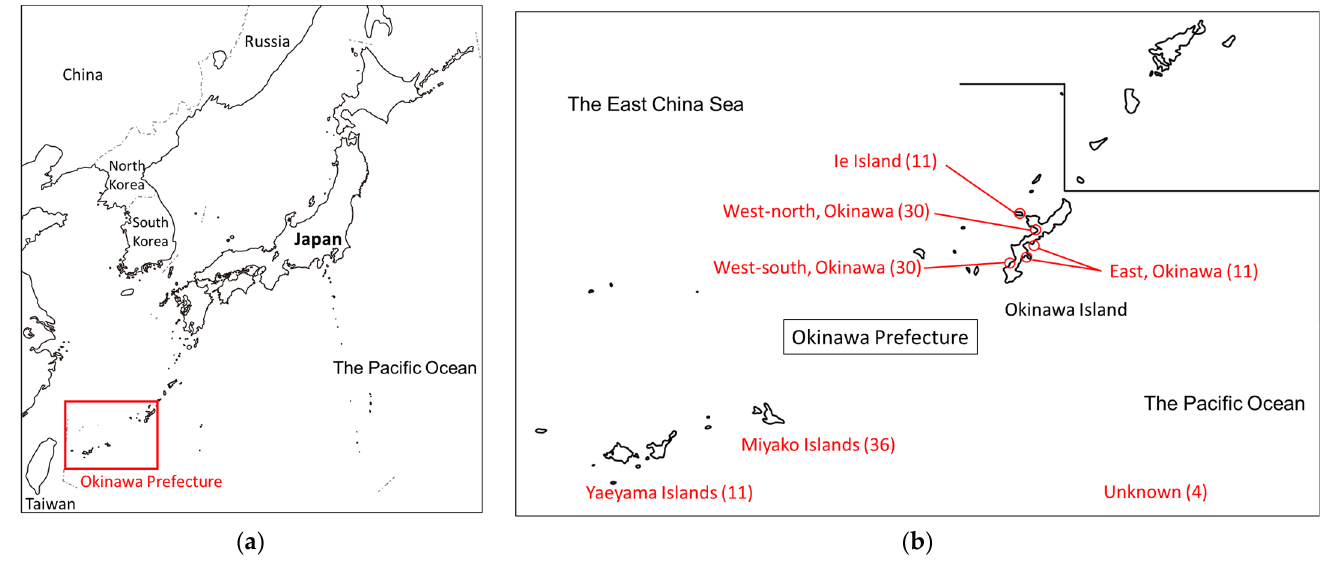
Figure 3. The location of collection sites of Variola albimarginata specimens from the Okinawan Islands, Japan. ( a ) Location of Okinawa; ( b ) Expansion of the red rectangle in ( a ). Numbers in parentheses indicate the number of specimens collected from each area.